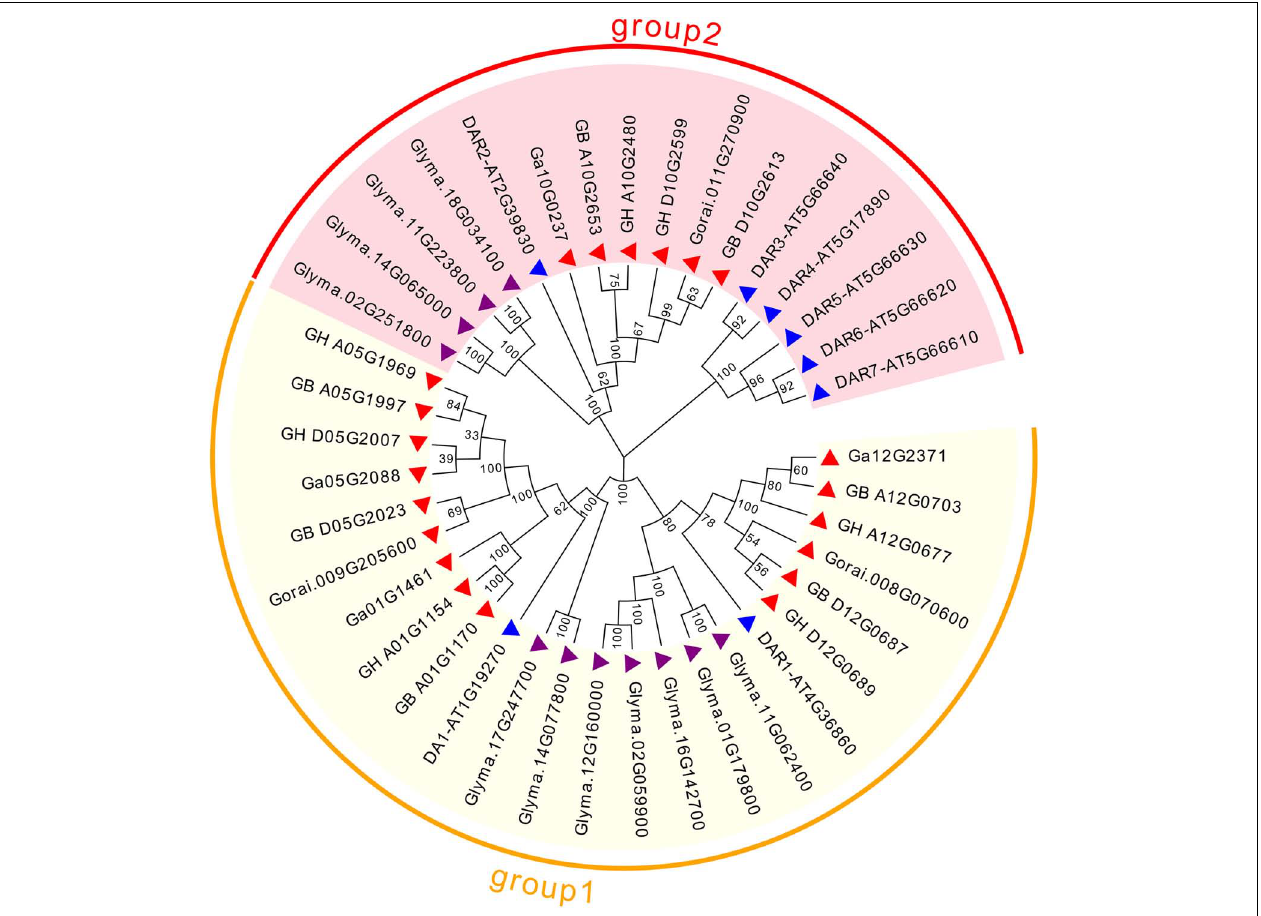
FIGURE 1 | Phylogenetic relationships of DA1-like genes from Gossypium, Arabidopsis , and soybean. Phylogenetic analysis was performed using the neighbor-joining method with 1,000 replicates. The DA1-like genes from Gossypium, Arabidopsis , and soybean are marked with red, blue, and purple triangles, respectively. Each group is indicated with a specific